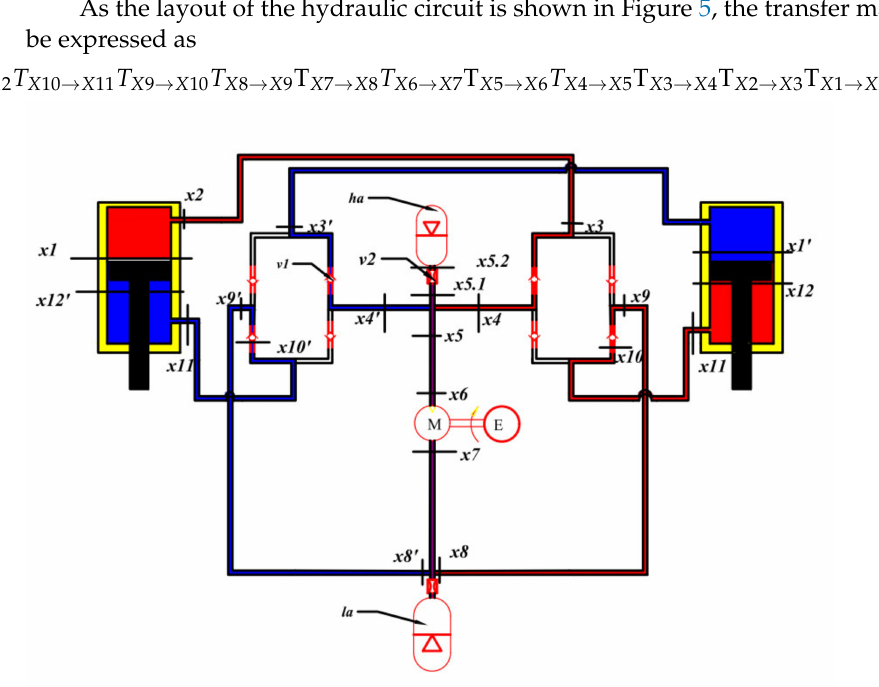
Figure 5. Schematic of a typical half-car with the HIIRS system. v1—check valves; la—low-pressure accumulator; ha—high-pressure accumulator; v2—accumulator valve; x, x (cid:48) —state